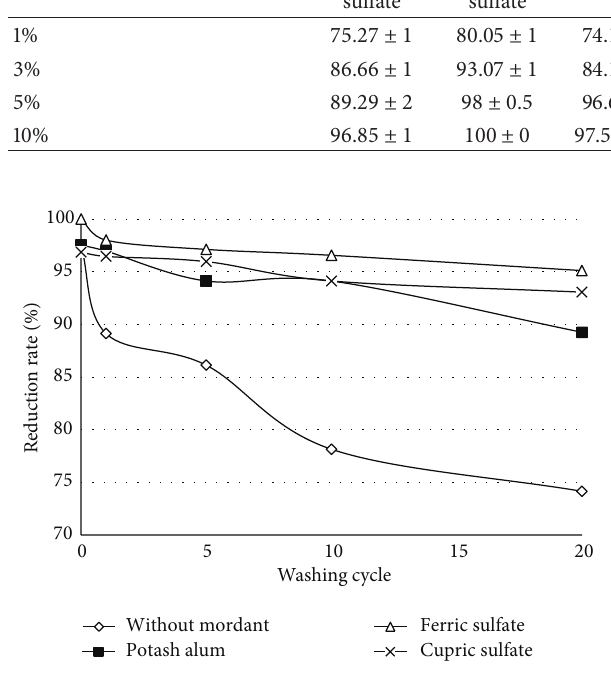
The extracted walnut concentration (O.W.F.%)